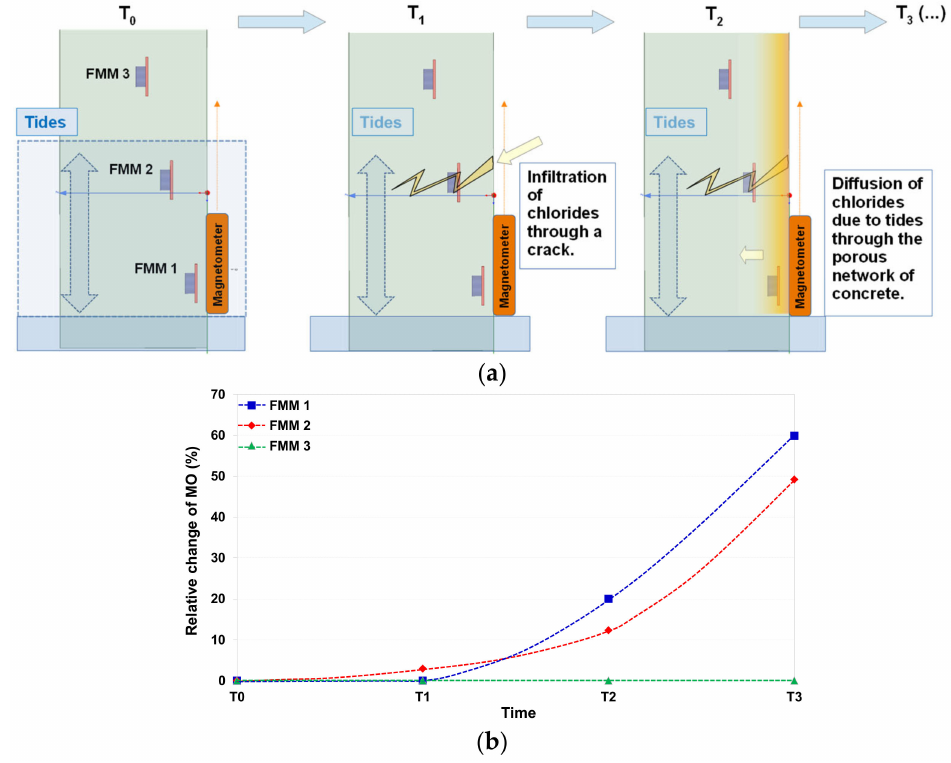
Figure 3. ( a ) Representation of three FMM devices—embedded at various depths in a reinforced concrete structure—subjected to tides at T 0 , with a crack inducing corrosion of the FMM 2 at T 1 , an additional aggressive agents’ front diffusing through FMM 1 at T 2 , and a continuation of induced corrosion phenomenon at T 3 . ( b ) Arbitrary representation of expected changes for the MO of each FMM, as a function of